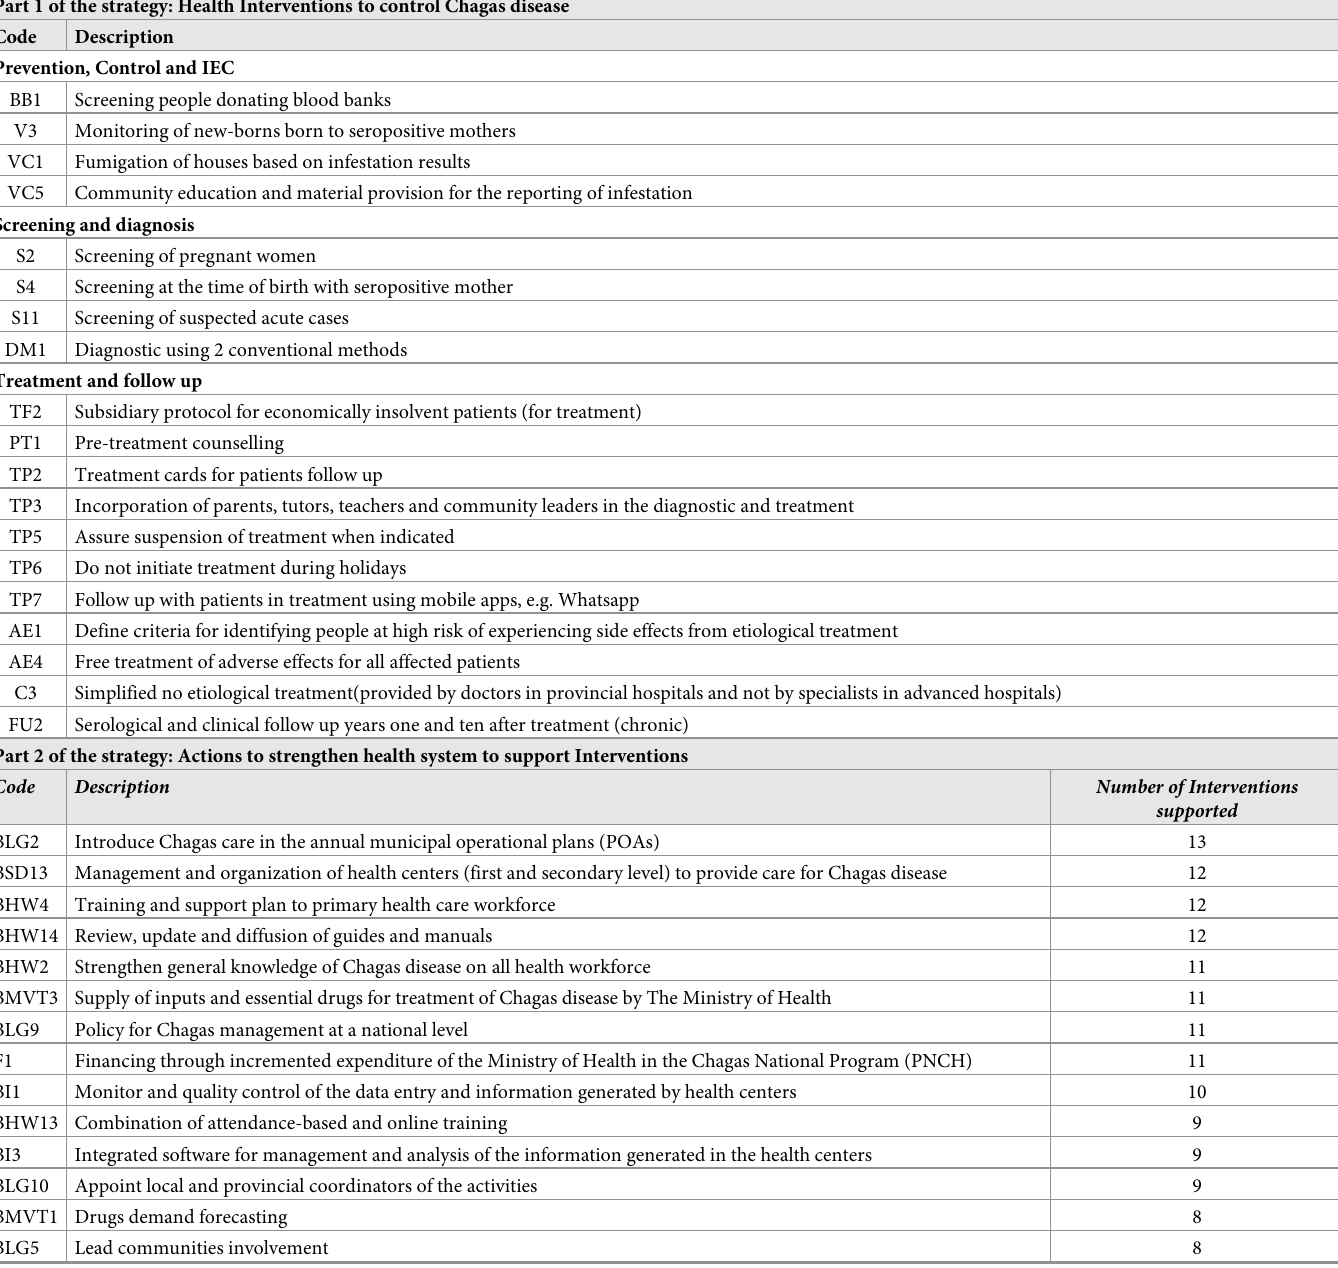
Table 3. Final Strategy proposed to control Chagas disease in Cochabamba,